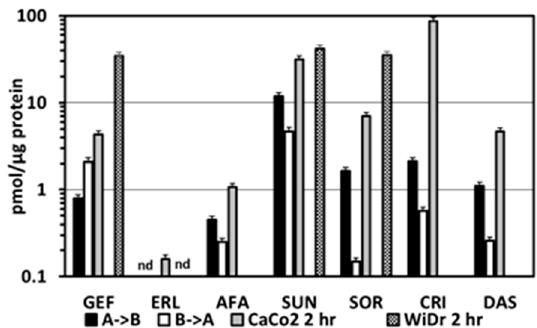
Figure 6. Accumulation of the TKIs in CaCo2 cells harvested at the end of the mass transport experiments in comparison to TKI accumulation in CaCo2 cells and WiDr colon cancer both grown as normal monolayers. These cells were exposed to 20 μ M of a TKI and were harvested after 2 h for determination of TKI concentration with LC-MS-MS. Values are means ± SEM for the number of experiments described in Figure 3, Figure 4, and Figure 5 and from three separate experiments for the monolayer CaCo2 and WiDr cells. GEF, gefitinib; ERL, erlotinib; AFA, afatinib; SUN, sunitinib; SOR, sorafenib; CRI, crizotinib; DAS, dasatinib; nd, not detectable. A->B, mass transport from A to B; B->A,